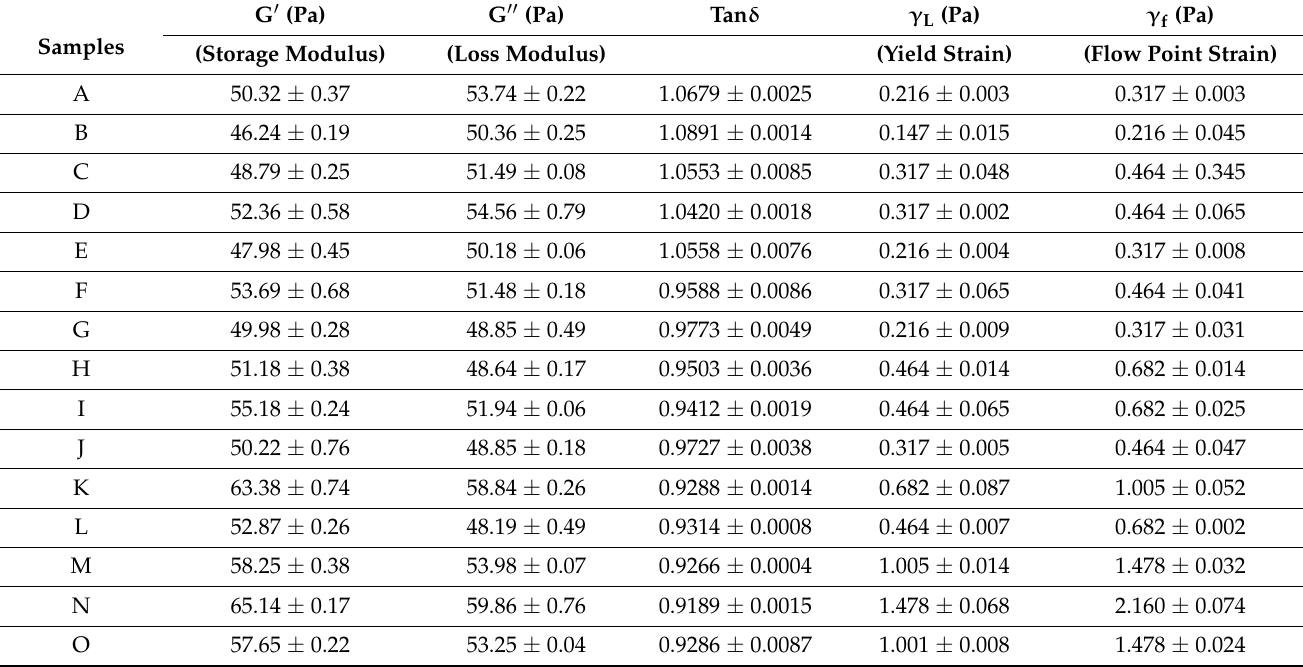
Table 4. Strain sweep parameters of the emulsions containing two hydrocolloids (fenugreek